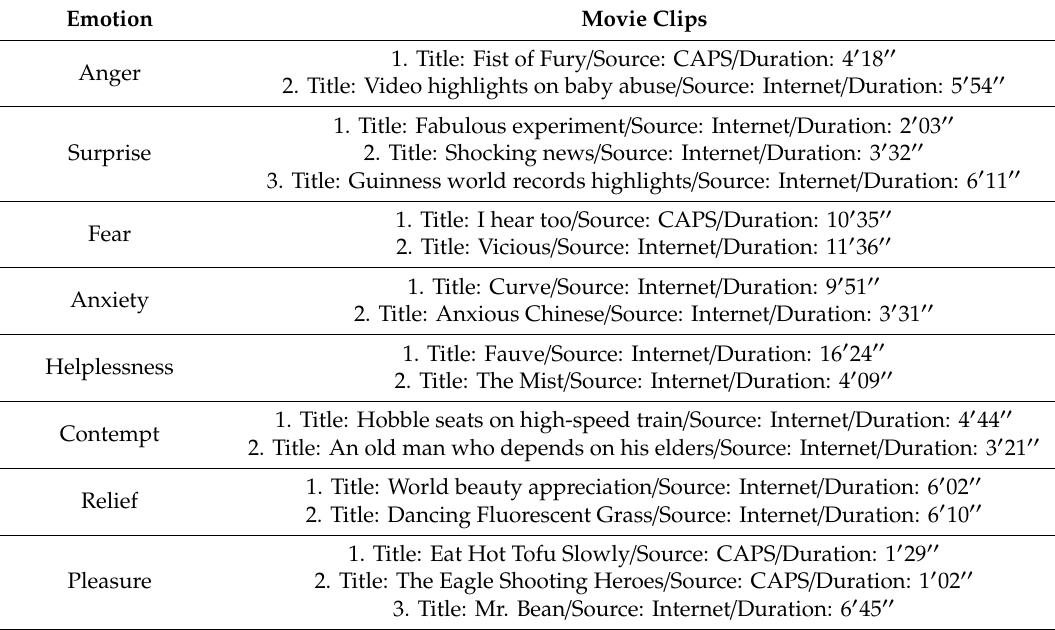
Table 6. Movie clips for emotion